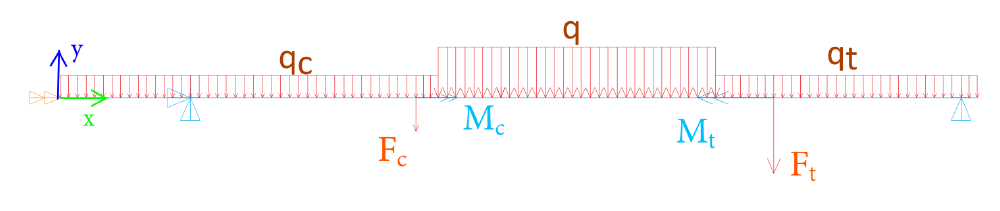
Figure 9. FE beam model and static scheme of the shaft